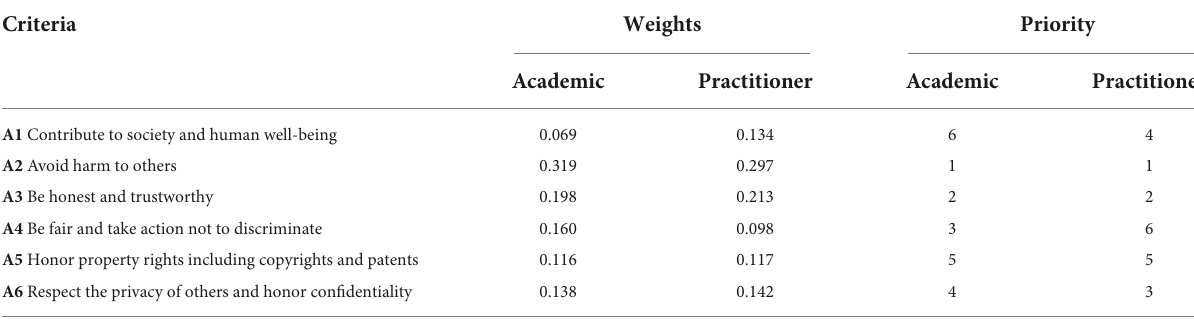
TABLE 7 Weights and ranking of general moral imperatives criteria by LIS experts.